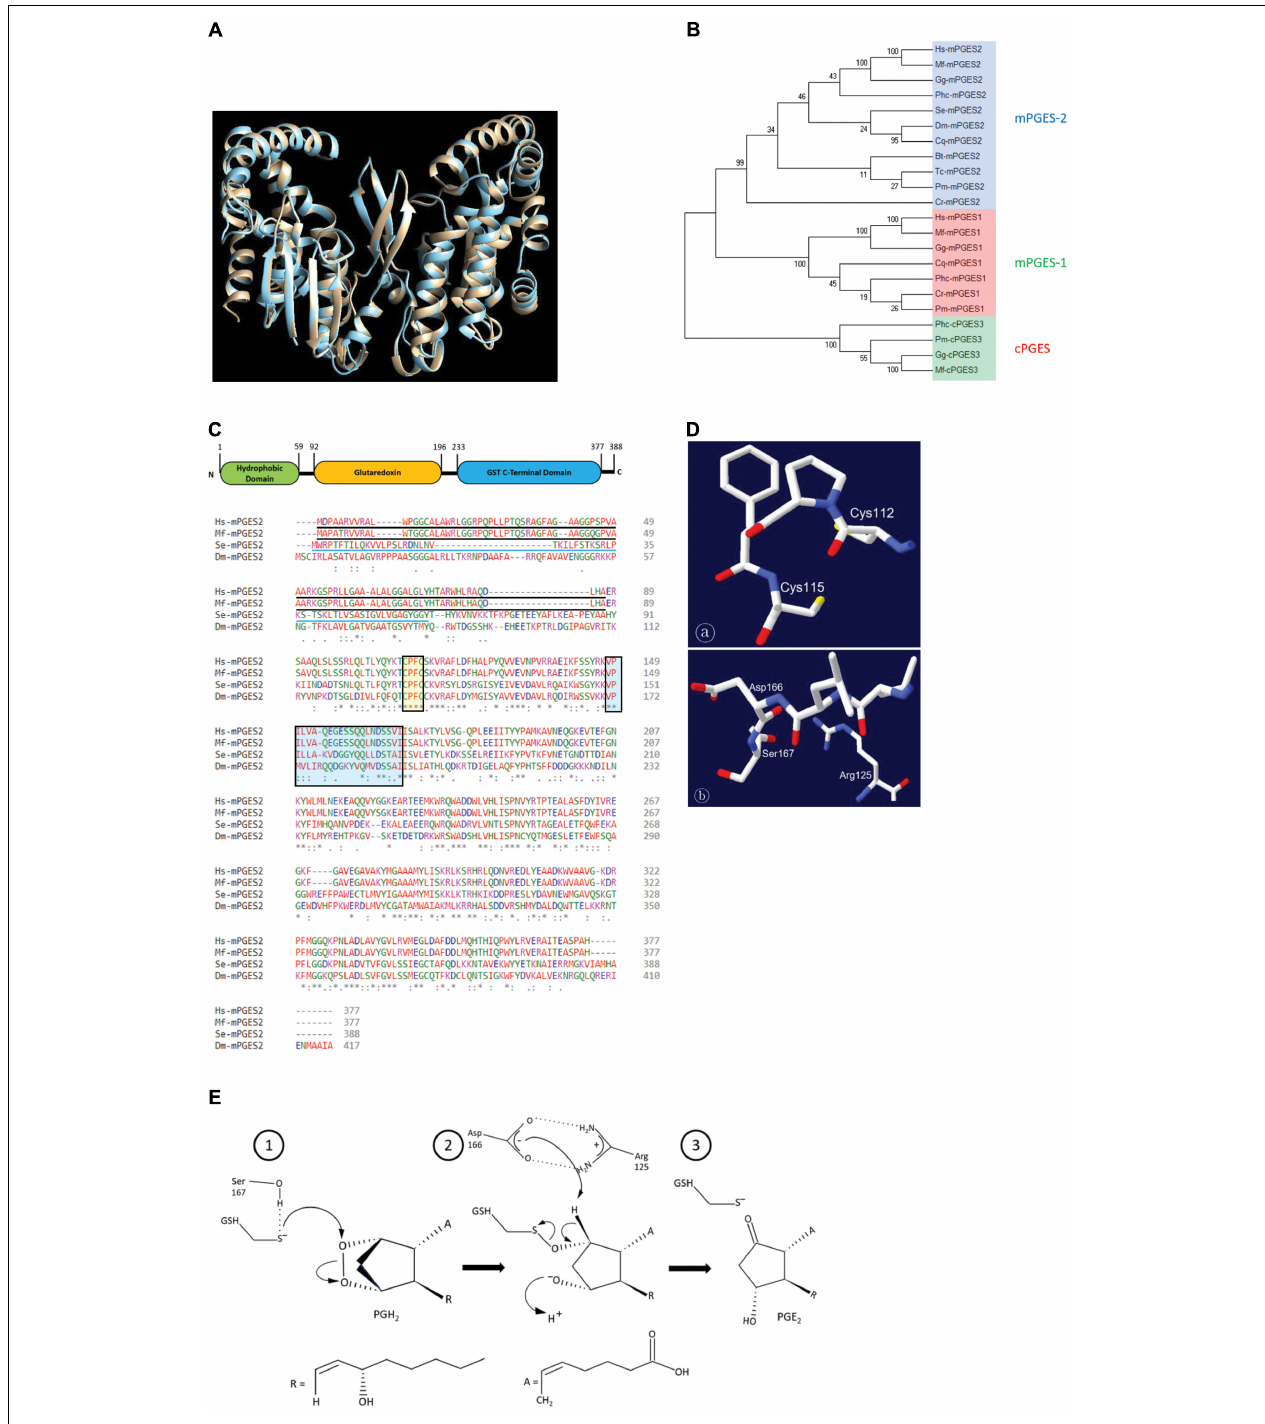
FIGURE 1 | Molecular characteristics of a S. exigua PGES ( Se-mPGES2 ). (A) Structural similarity of Se-mPGES2 to a primate mPGES2. A superimposed view of Macaca fascicularis mPGES-2 crystal structure (gray) and the predicted three-dimensional structure of Se-mPGES2 (blue). Superimposition analysis was performed by UCSF Chimera (https://www.cgl.ucsf.edu/chimera/). (B) A phylogenetic analysis of Se-mPGES2 . The analysis was performed using MEGA6. Bootstrapping values were obtained with 1,000 repetitions to support branching and clustering. Amino acid sequences of selected mPGES2 genes were retrieved from GenBank: NP_004869.1 for Homo sapiens (Hs-mPGES1), ADK66307.1 for Gallus gallus (Gg-mPGES1), AAS89037.1 for M. fascicularis (Mf-mPGES-1), ACO11433.1 for Caligus rogercresseyi (Cr-mPGES1), AFJ11395.1 for Penaeus monodon (Pm-mPGES-1), XP_001863047.1 for Culex quinquefasciatus (Cq-mPGES1), EEB10983.1 for Pediculus humanus corporis (Phc-mPGES1), NP_079348.1 for H. sapiens (Hs-mPGES2), XP_415498.1 G. gallus (Gg-mPGES2), BAB01608.1 for